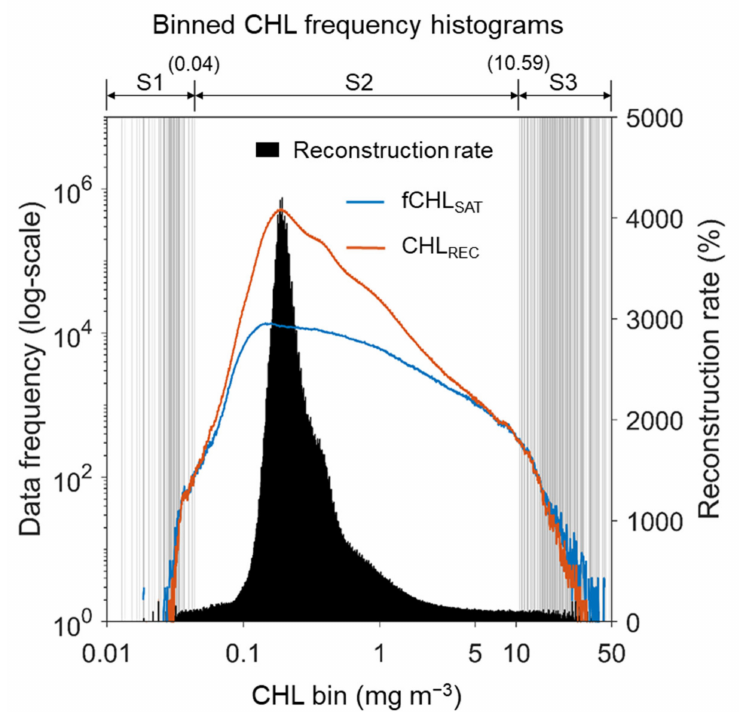
Figure 6. Binned CHL-frequency histograms of both filtered CHL SAT (fCHL SAT , blue line) and the reconstructed CHL estimates from the RF models (CHL REC , orange line) on logarithmic scales. The bars denote the reconstruction rate of CHL REC (black) at each CHL bin. Bins were determined by logarithmically dividing the CHL ranges from 0.01 to 50 mg m − 3 into 1000 bins. Vertical gray lines indicate the location of the bin with the failure of the reconstruction, implying the underestimation of the machine-learning models or the preservation of CHL SAT . Degments (S1 to S3) were defined based on the phase of the reconstruction rate from the RF